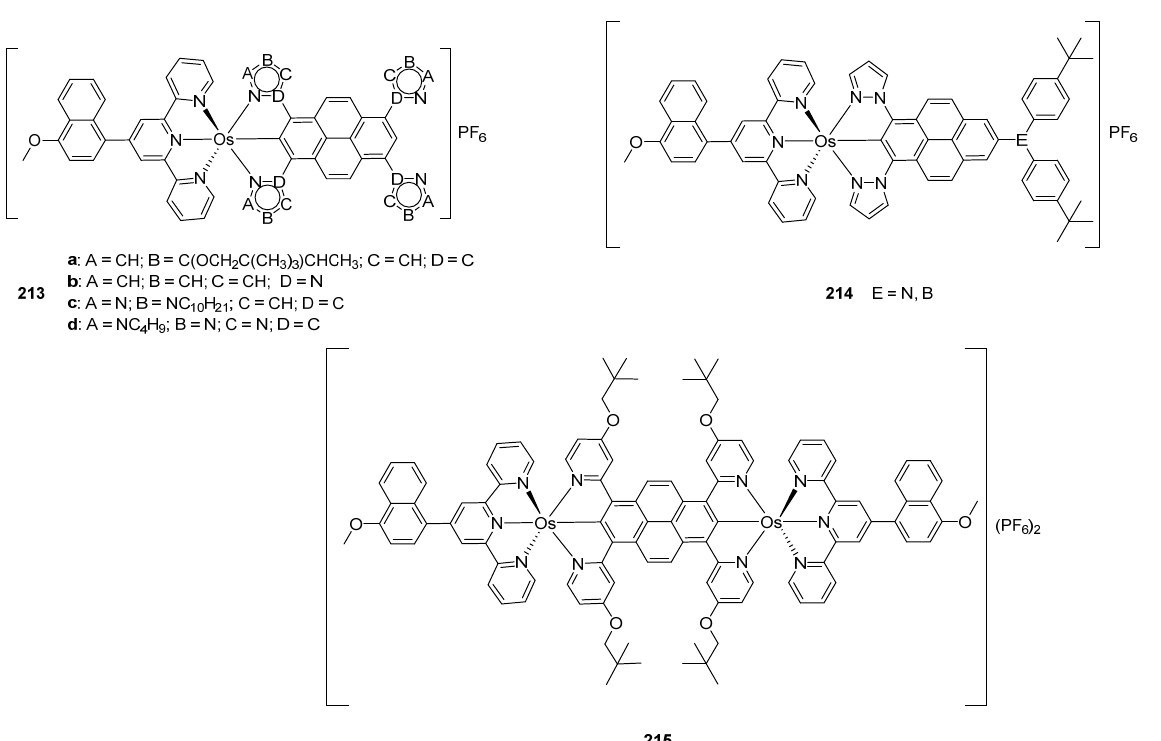
Figure 54. Luminescent bis -pincer complexes with cyclometalated pyrene-type ligands.